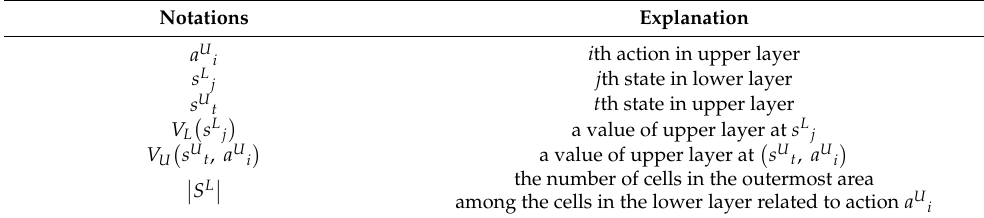
Table 1. Explanation of notations in Section